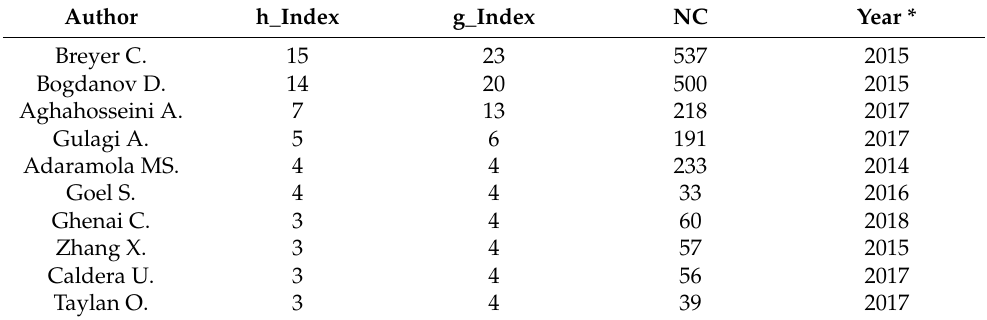
Table 6. Authors Impact (LCOE).